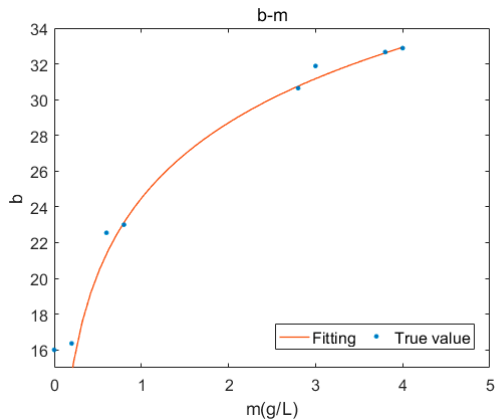
Figure 2. The relationship between b and m .